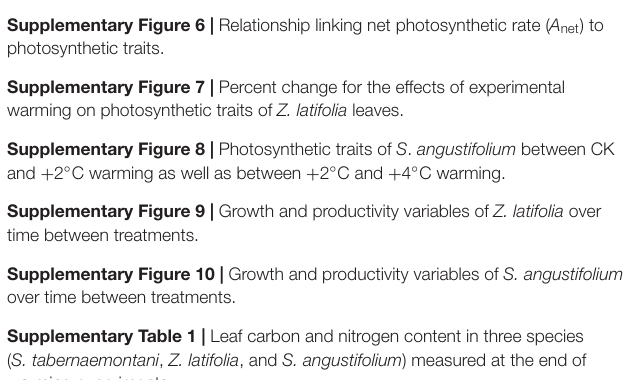
Supplementary Figure 1 | Mean temperature over the whole of 2016. Supplementary Figure 2 | Monthly based maximum and minimum temperature records over the whole of 2016. Supplementary Figure 3 | Daytime and nighttime temperature records over the whole of 2016. Supplementary Figure 4 | Extreme temperature records over the whole of 2016. Supplementary Figure 5 | Air relative humidity records. Supplementary Figure 6 | Relationship linking net photosynthetic rate ( A net ) to photosynthetic traits. Supplementary Figure 7 | Percent change for the effects of experimental warming on photosynthetic traits of Z. latifolia leaves. Supplementary Figure 8 | Photosynthetic traits of S . angustifolium between CK and + 2 ◦ C warming as well as between + 2 ◦ C and + 4 ◦ C warming. Supplementary Figure 9 | Growth and productivity variables of Z. latifolia over time between treatments. Supplementary Figure 10 | Growth and productivity variables of S. angustifolium over time between treatments. Supplementary Table 1 | Leaf carbon and nitrogen content in three species ( S. tabernaemontani , Z. latifolia , and S. angustifolium ) measured at the end of warming